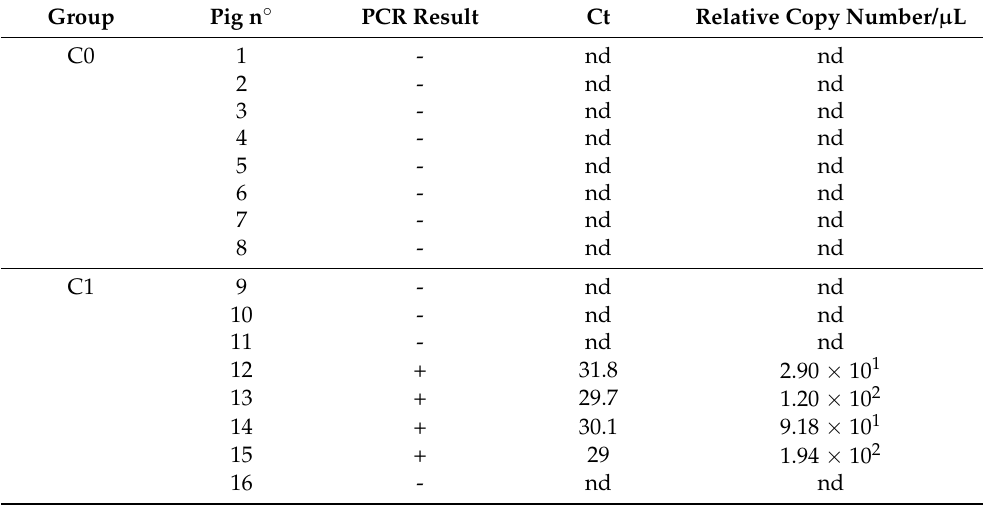
Table 2. Mycoplasma hyopneumoniae molecular detection and quantification results. nd: not determined.